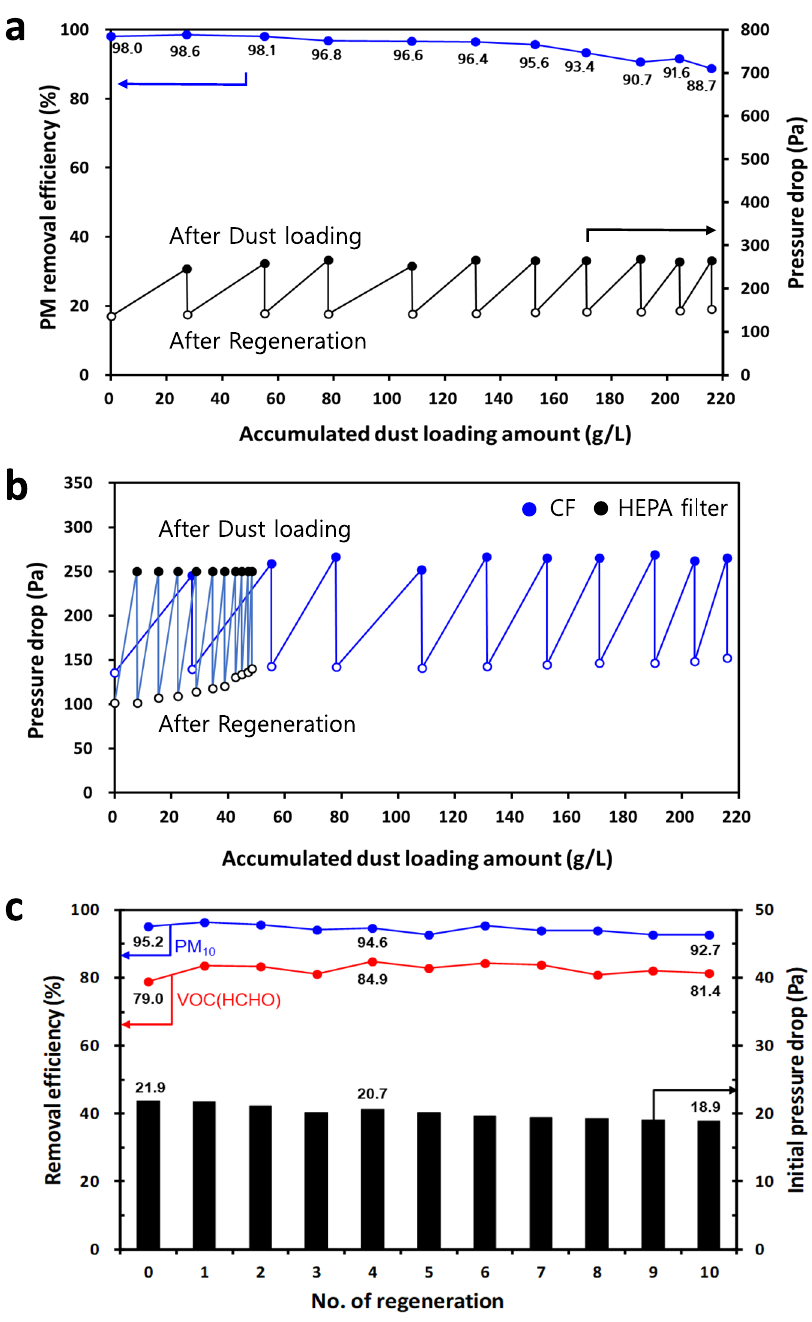
fi lter (Black: total dust loading amount, 48.4g/L, average 4.8g/L) according to regeneration cycleswith waterwashing. c Simultaneous PM FE and VOC REof CCF for ten regenerations by water